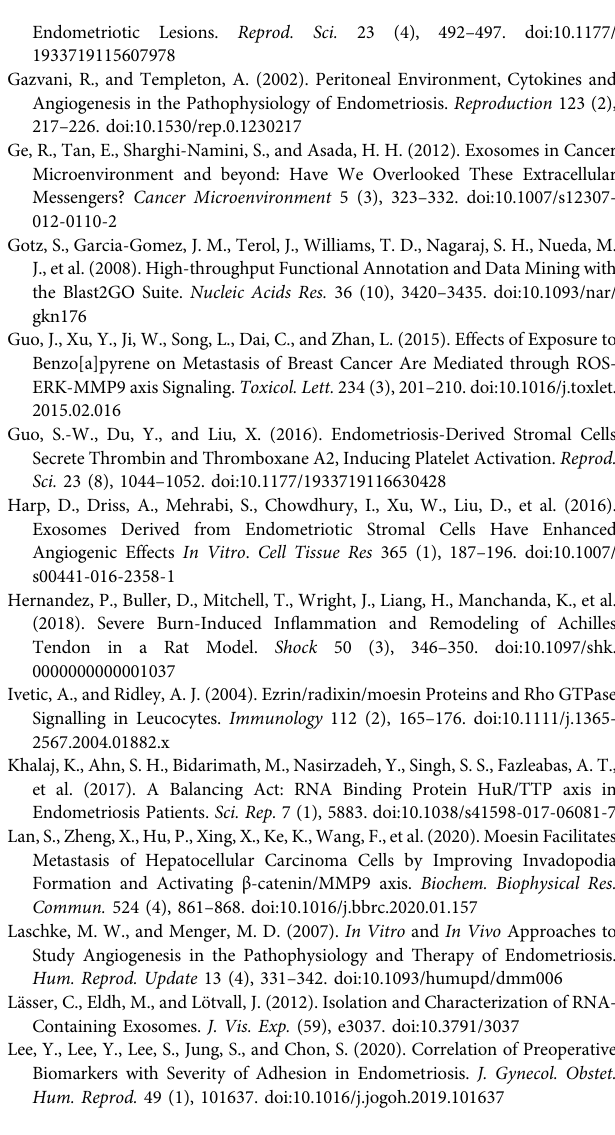
Supplementary Table S3 | List of three up-regulated proteins and six down-